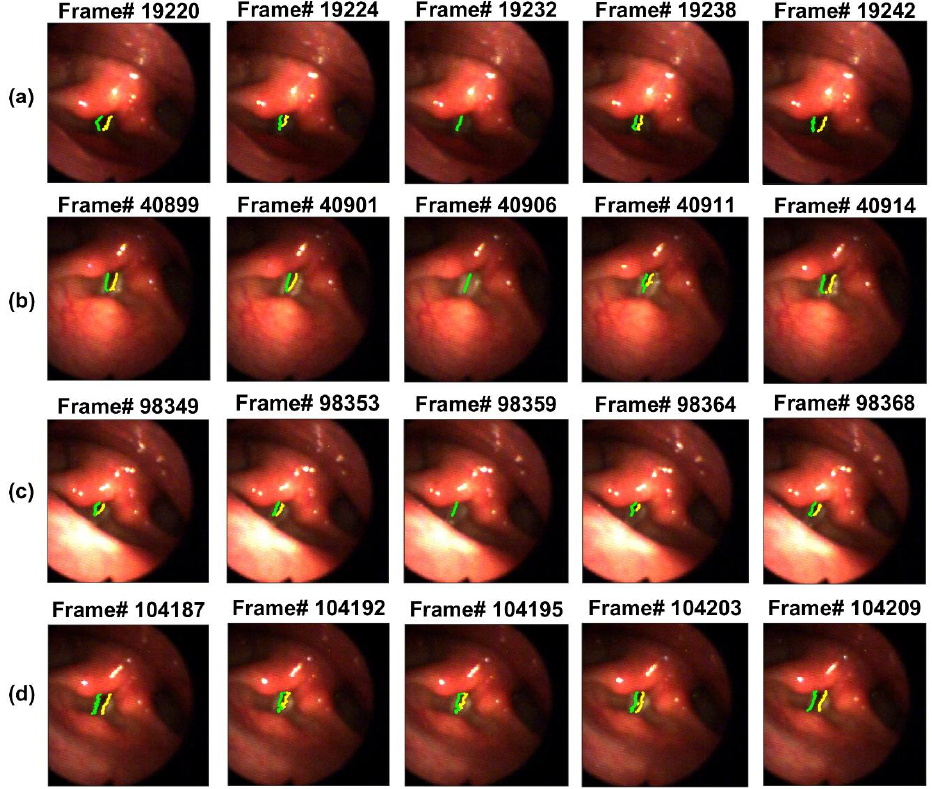
Figure 6. Five HSV frames from four different vocalizations (Panel ( a – d ): between Frame 18,975 – 19,803, 40,505 – 41,255, 98,105 – 98,651, and 103,942 – 104,577) after applying the hybrid method and spatially registering the edges of the vibrating vocal folds.